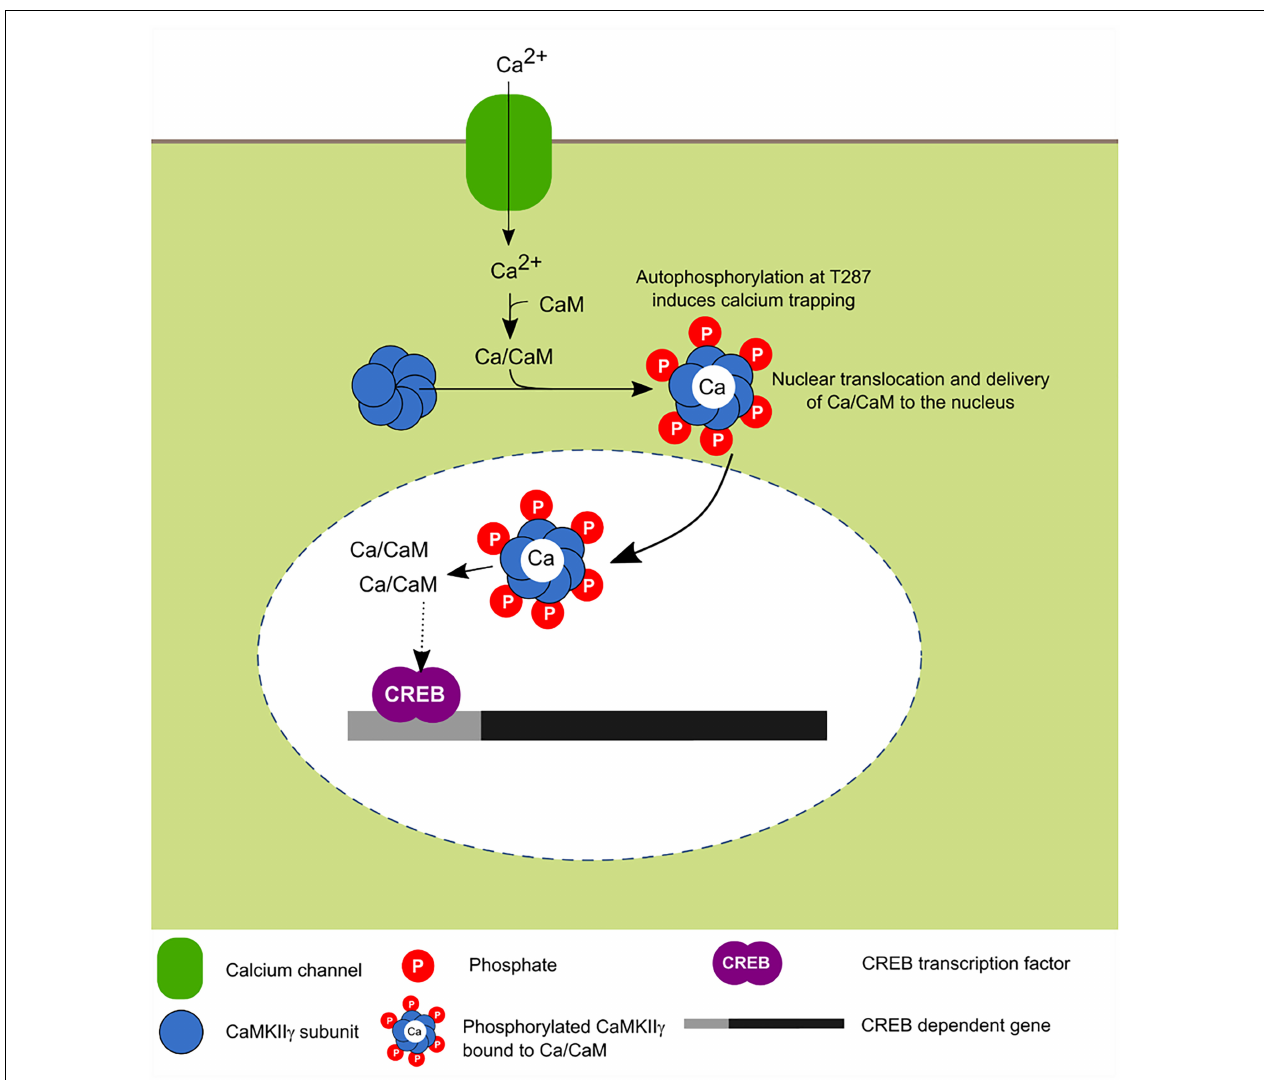
FIGURE 5 | Activity-dependent nuclear translocation of CaMKII γ . Recent findings propose that neuronal activity induces CaMKII γ nuclear translocation whose main role is to shuttle Ca 2 + /CaM to the nucleus, this leads to the phosphorylation of CREB transcription factor which is associated with enhanced transcription (Ma et al., 2014; Malik et al.,